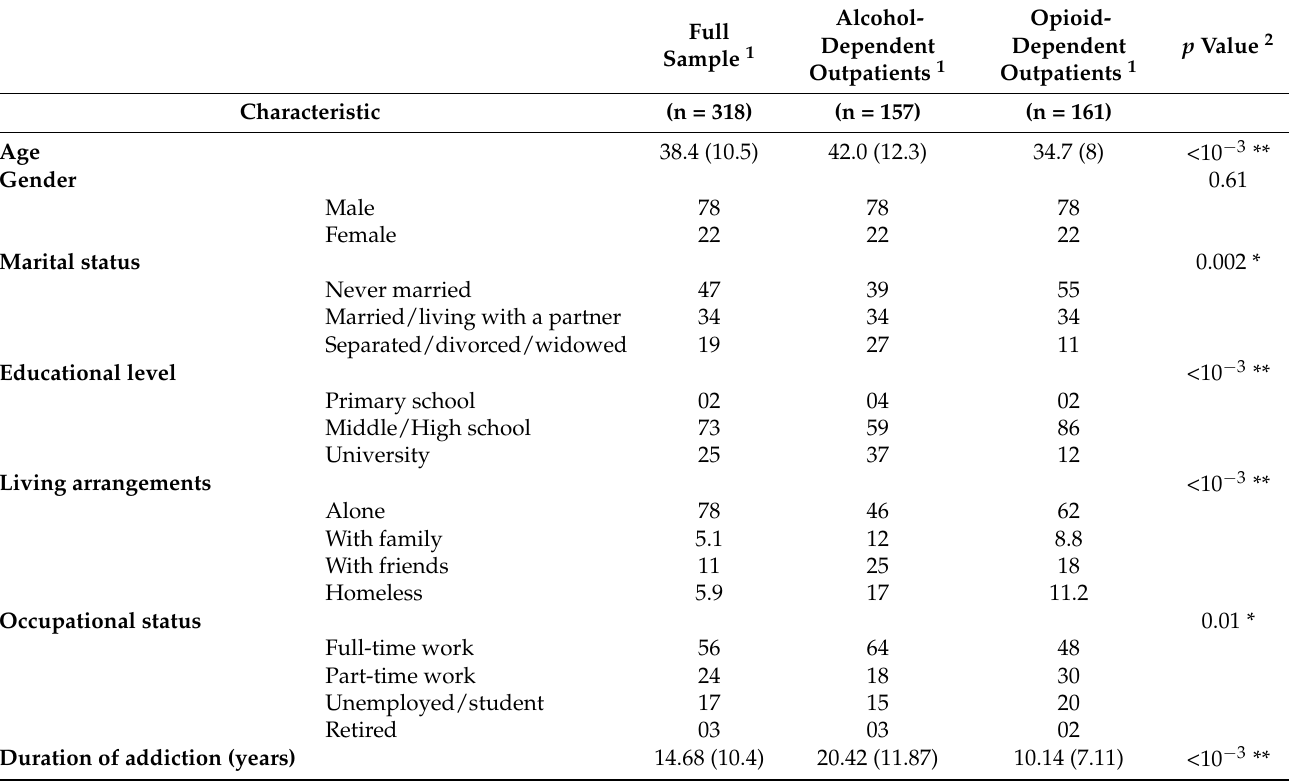
Table 2. Main social and clinical characteristics of the